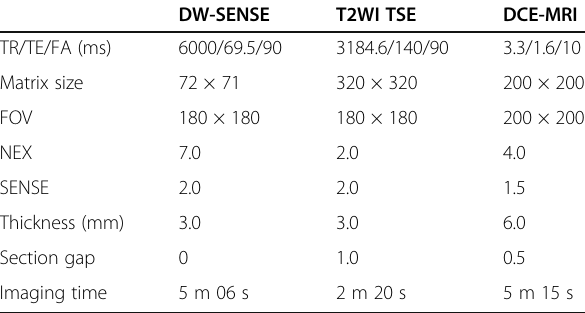
Table 2 Protocols of each sequence of prostate